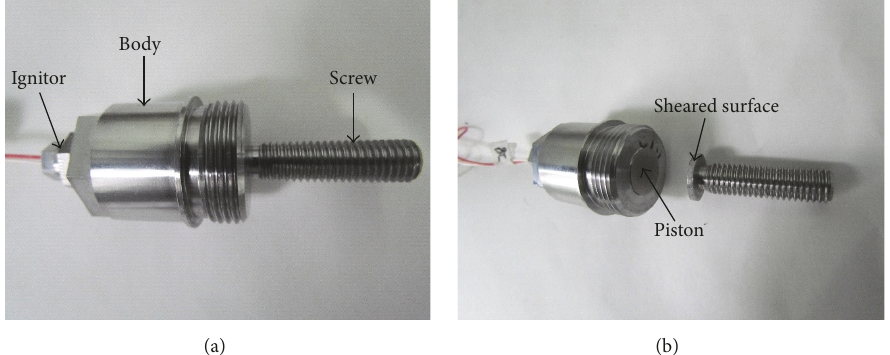
Figure 3: Pictures of shear type explosive bolts: (a) before separation and (b) after